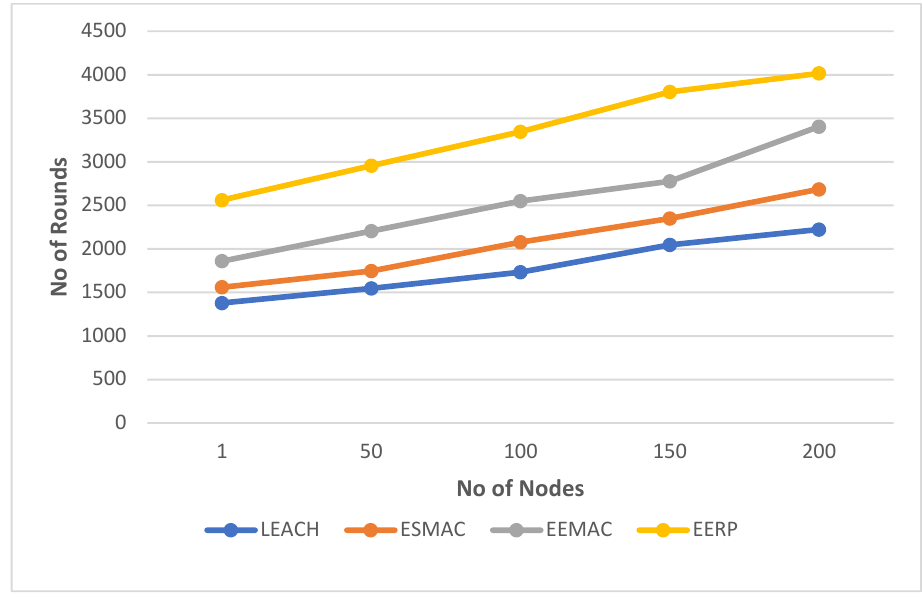
Figure 14. Simulation result in Scenario 4.